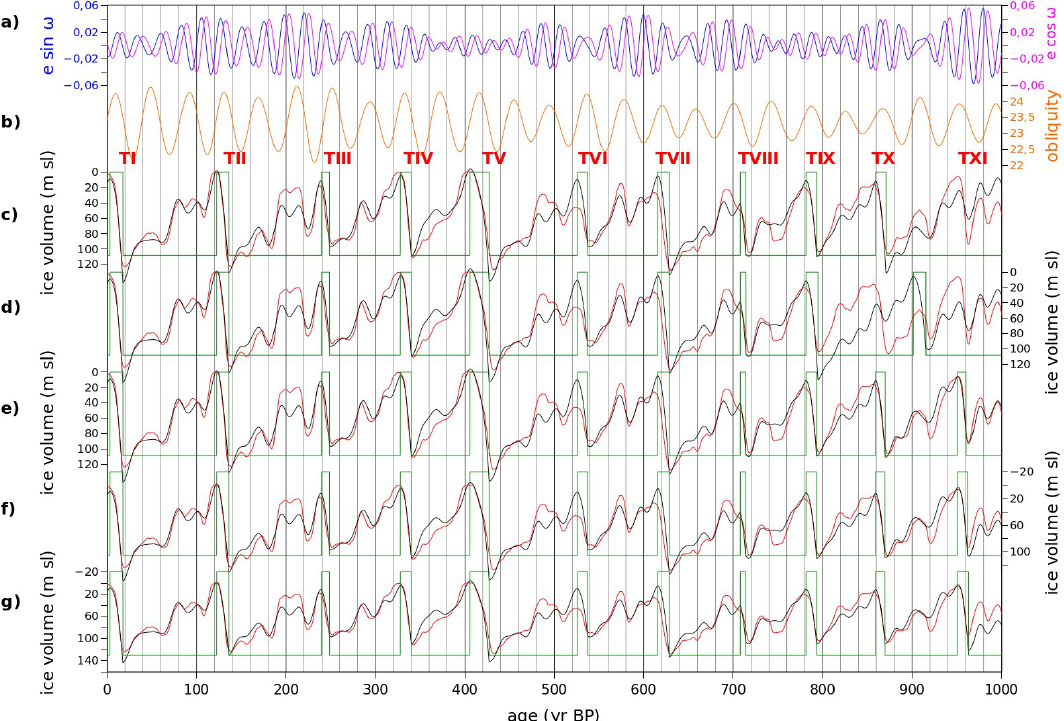
241 Fig. 4. Model orbital forcings (Laskar et al., 2004), ice volume data (Bintanja et al., 2005), and model experiments. Terminations are marked with red roman numbers. From top to bottom: (a) precession parameters e sin ω and e cos ω . (b) Obliquity parameter. (c) Red: ice volume data; Black: model experiment similar to Best but with vinit=15m; Green: model state. (d) Red: ice volume data; Black: model experiment similar to Best but with vinit=30m; Green: model state. (e) Red: ice volume data; Black: model experiment similar to Best but with vinit=45m; Green: model state. (f) Red: ice volume data; Black: model experiment similar to Best but with vinit=60m; Green: model state. (g) Red: ice volume data; Black: model experiment similar to Best but with vinit=75m; Green: model